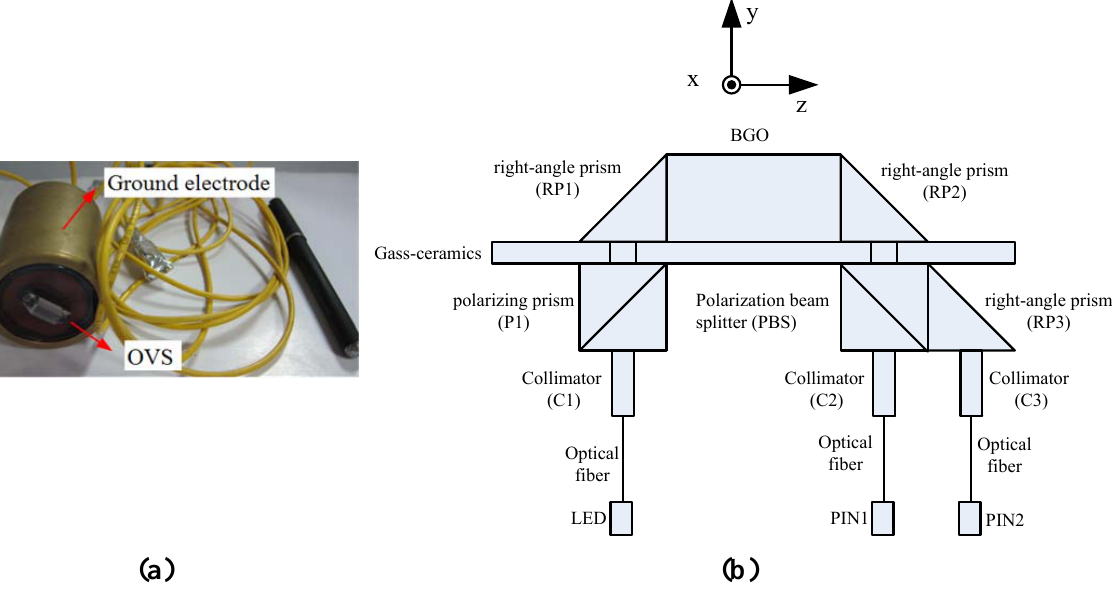
Figure 2. (a) Photo of the OVS. (b) Setup of the